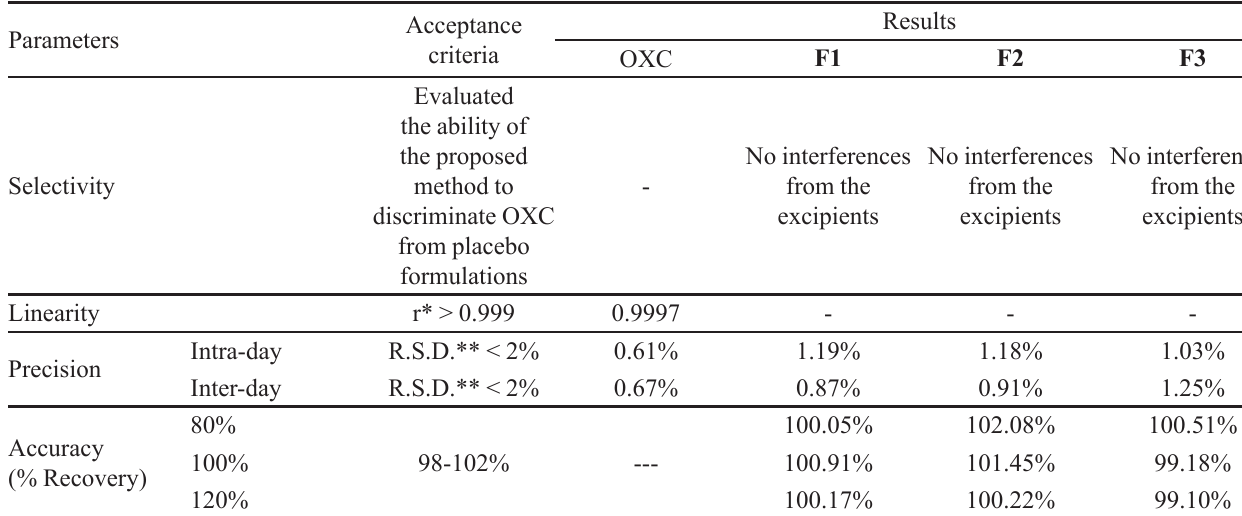
TABLE II - Validation parameters for UV method of analysis of OXC